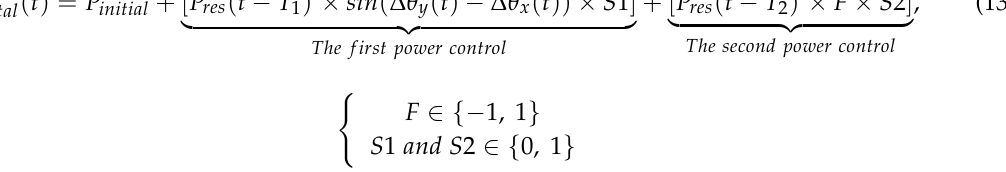
Figure 5. The second power control model of BTB VSC.